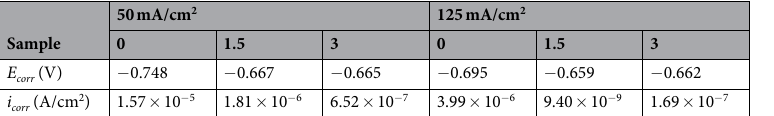
Table 3. Extrapolation results of the potentiodynamic polarization curves of the PEO coatings formed on an Al-Mg-Si alloy by PEO for 8 min using different concentrations of Na 3 AlF 6 at different current